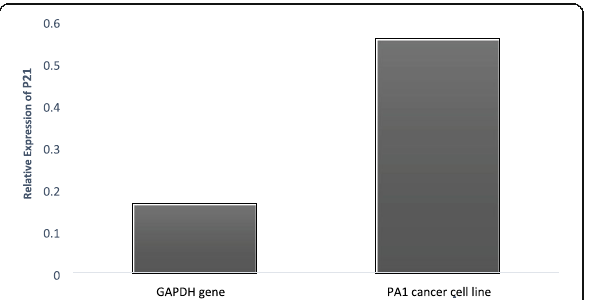
Fig. 7 Relative expression of p21 compared to GAPDH gene on the control and treated sample of PA1 cancer cell